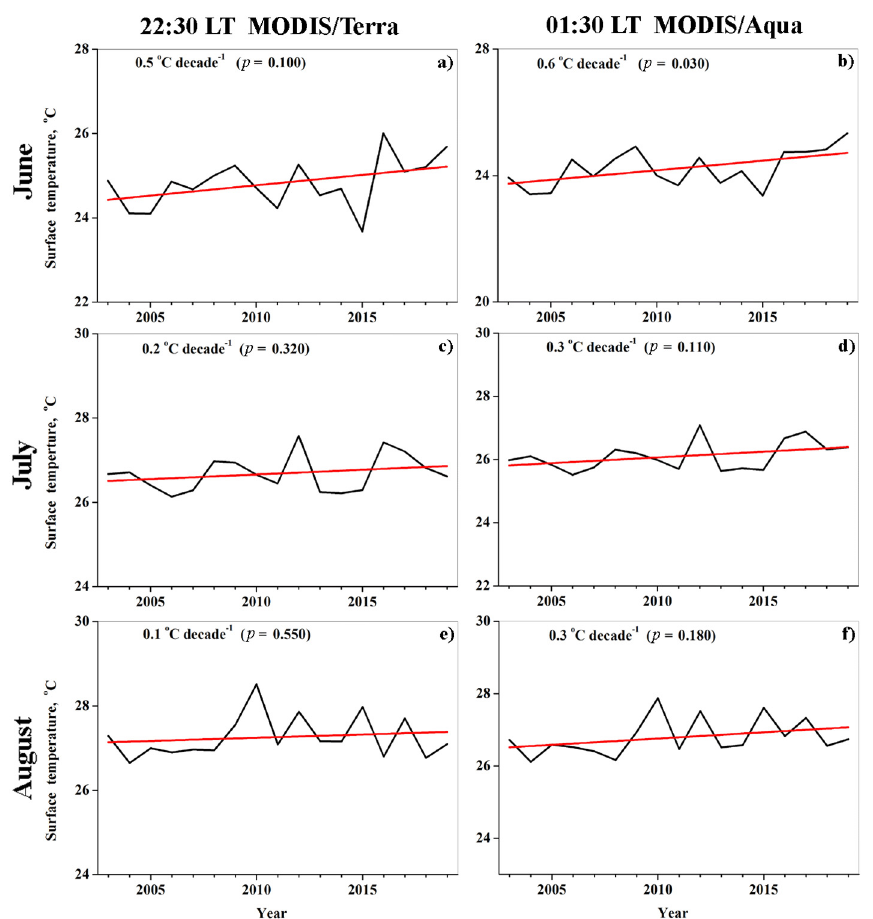
Figure 13. Satellite-based MODIS trends in nighttime SWT (averaged over the whole Kinneret water area), in the summer months, based on ( left column ) ( a , c , e ) MODIS/Terra data at 22:30 LT and on ( right column ) ( b , d , f ) MODIS/Aqua data at 01:30 LT. The top panel ( a , b ) corresponds to June, the middle panel ( c , d ) corresponds to July, and the bottom panel ( e , f ) corresponds to August. The straight red lines designate linear fits.